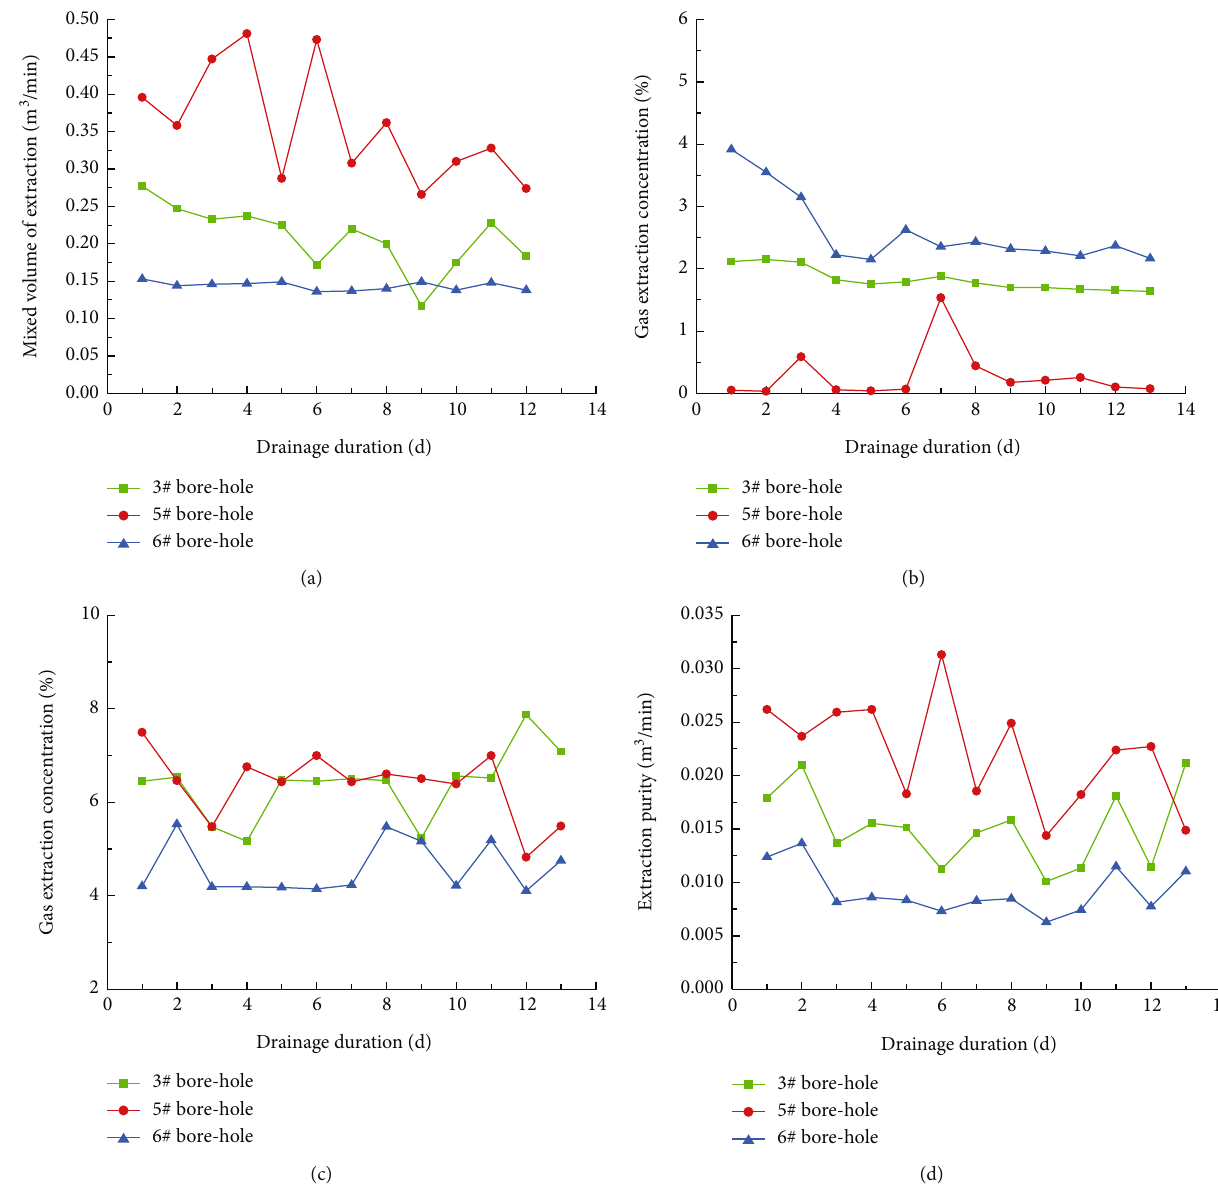
Figure 23: Gas drainage in boreholes 3 #, 5 #, and 6